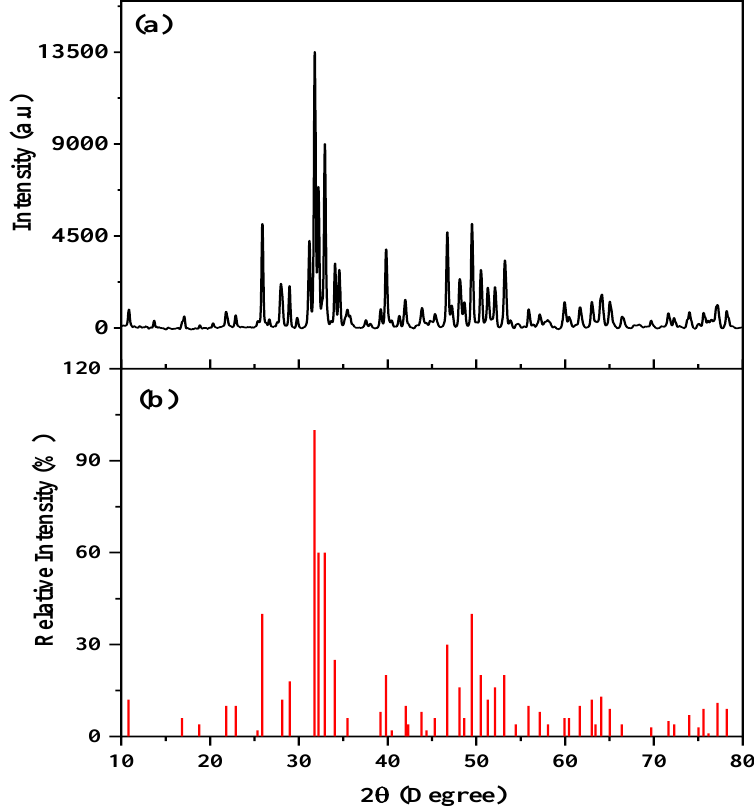
Figure 3. XRD patterns of ( a ) FsHA powder and ( b ) JCPDS No. 00-009-0432.